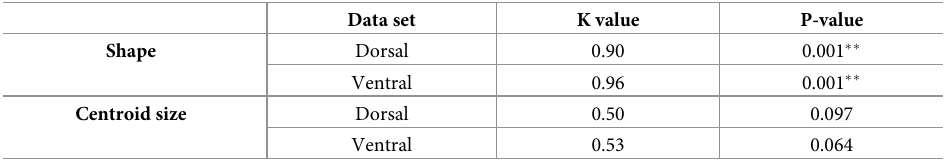
Table 3. Phylogenetic signal detected in size and